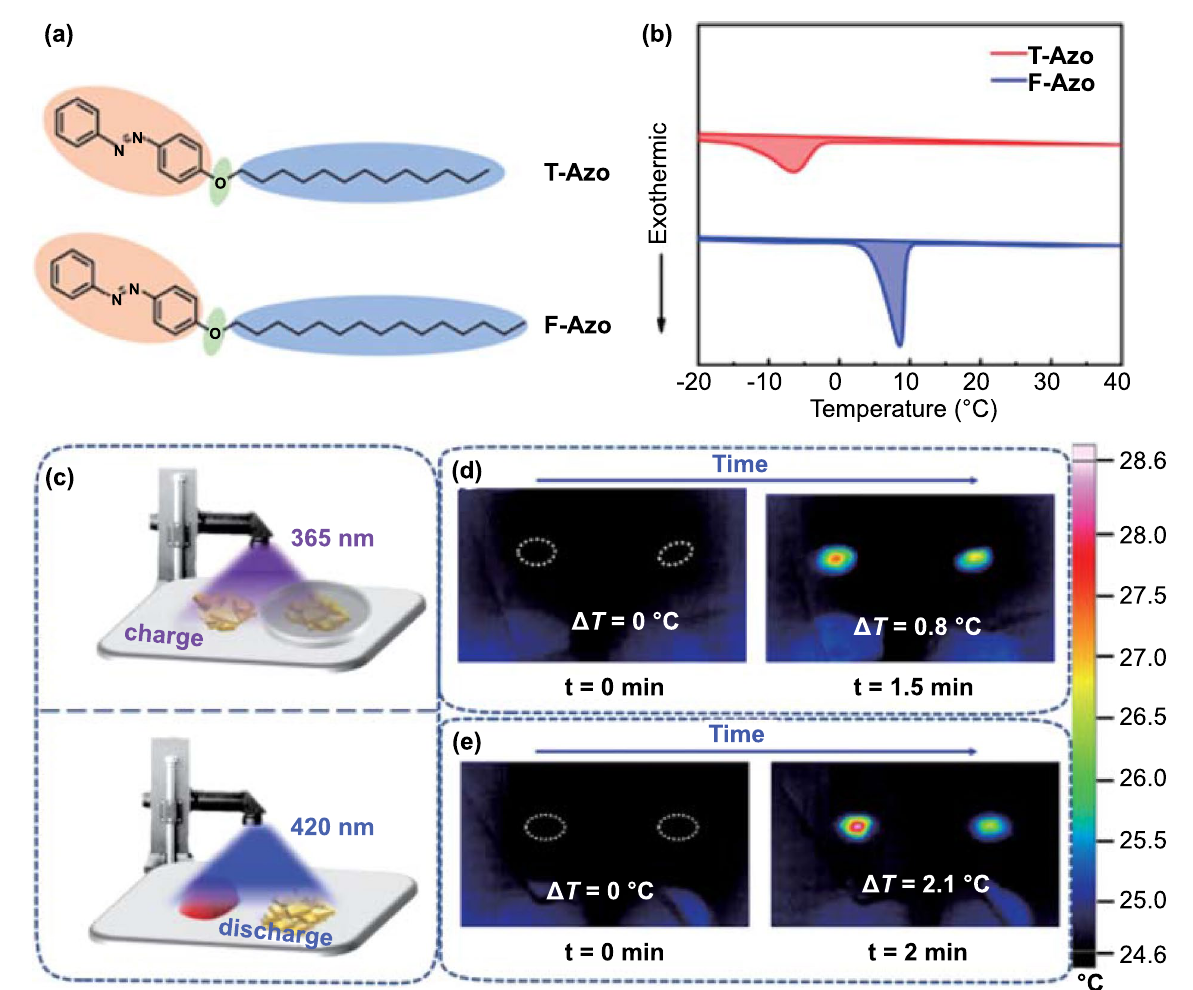
Fig. 4 a Chemical structure of T-Azo and F-Azo (the red part represents the isomerization unit, the green part represents flexible linker, and the blue part represents the phase change unit). b DSC traces of charged T-Azo (red line) and F-Azo (blue line) measured by cooling from 40 to − 20 °C, c Schematic of energy storage under UV light (365 nm) irradiation and release at 25 °C induced by blue light (420 nm). IR thermal image of the charged d T-Azo and e F-Azo irradiated with blue light [86]. (Color figure